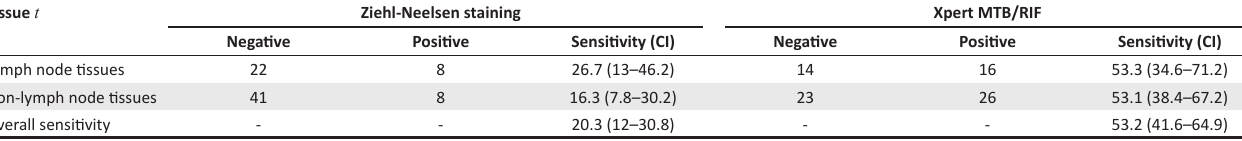
TABLE 3: Yield of Ziehl-Neelsen and Xpert MTB/RIF test by tissue type. Tissue